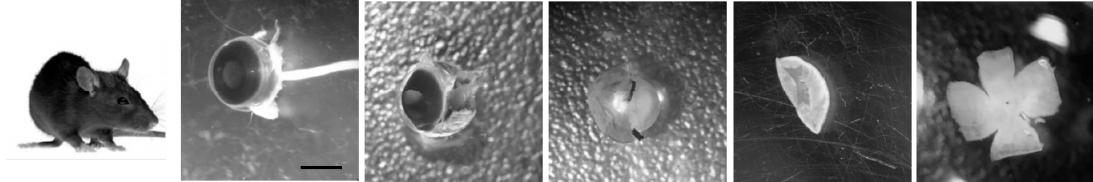
Figure 2. Isolation of adult mouse retina. After dissection, the retina is flattened by creating four incisions from the periphery to the centre, as shown in the last panel. This allows better adherence to a nitrocelullose membrane for easier handling. Scale bar: 2 mm.